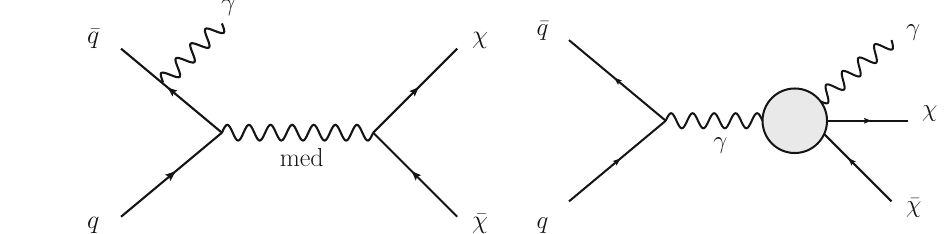
Fig. 1 Pair production